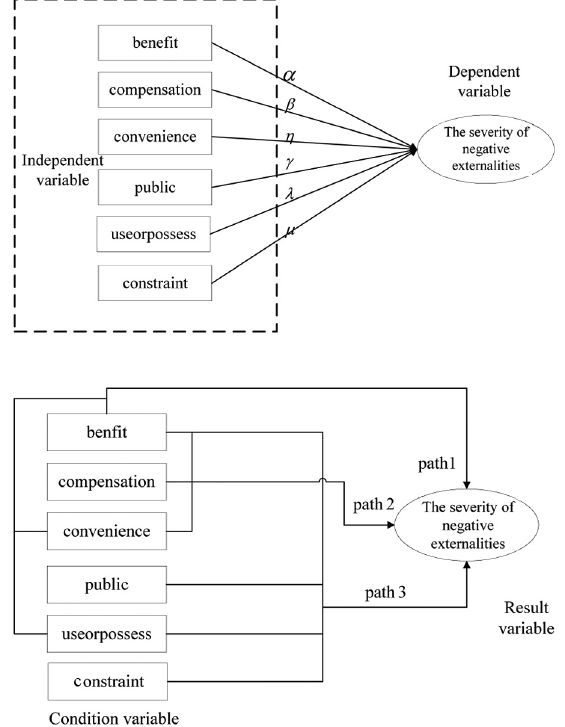
Figure 2. Schematic diagram